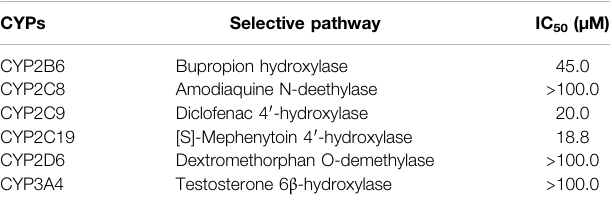
TABLE 3 | CYPs-selective metabolic pathways inhibition mediated by ticagrelor- O-Glu.